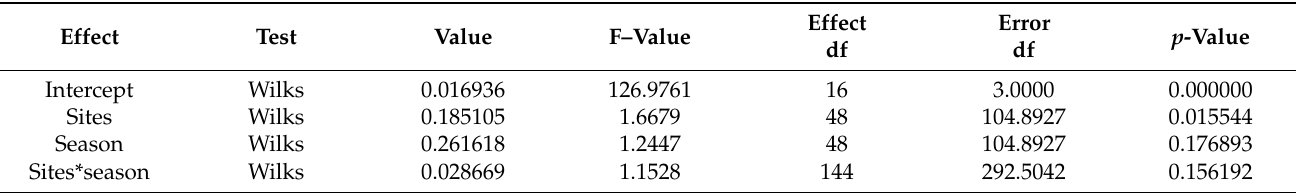
Table 3. Multivariate analysis of variance MANOVA results for suspended sediment grain size distribution between sites and seasons, indicating significant difference ( p < 0.05) between sites during the study period (August 2016–March